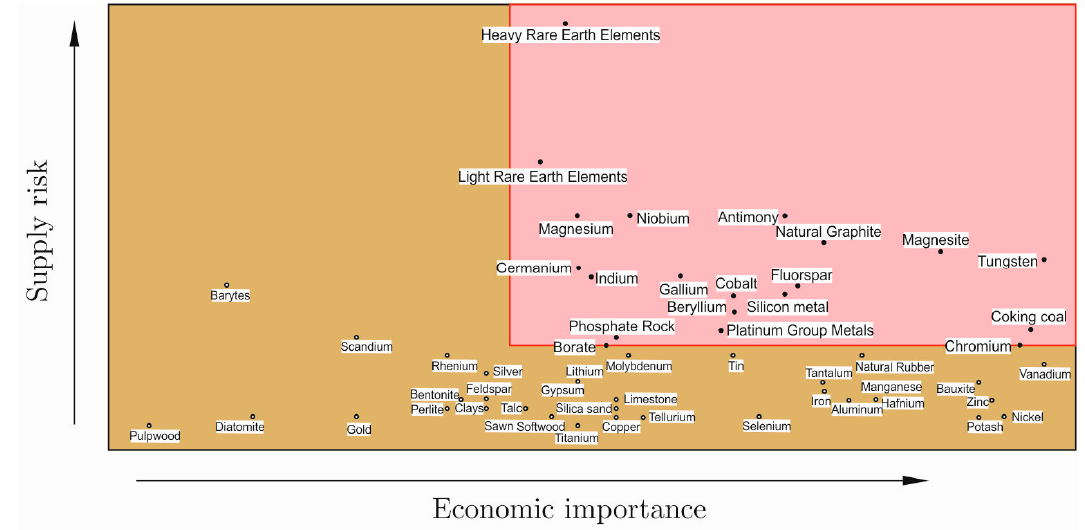
Figure 1. List of critical raw materials (CRMs) for the EU. Elements in the pink box are the 20 considered as most critical (reprinted from [2]).